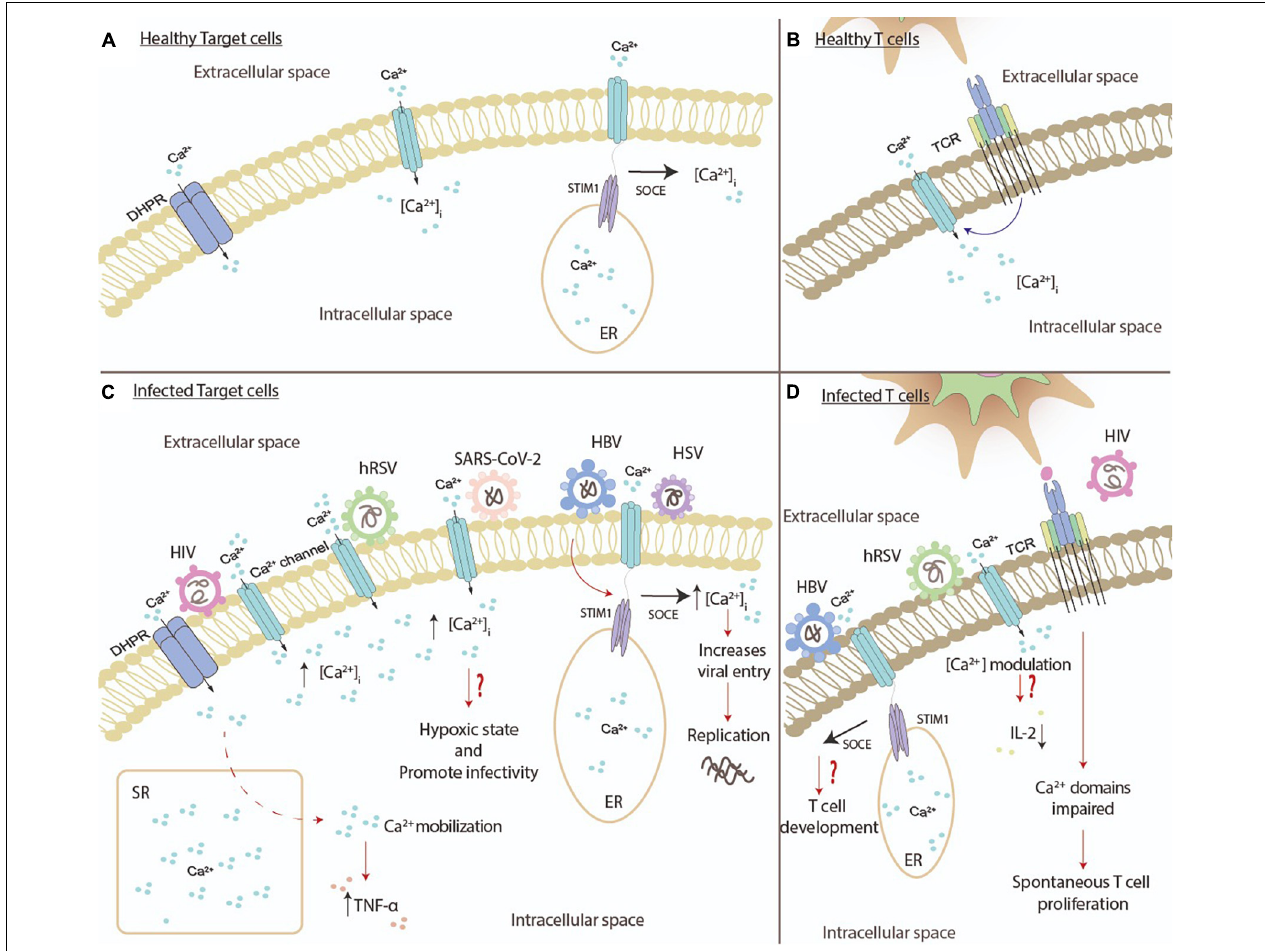
FIGURE 3 | Viral pathogens modify biological processes on immune cells by increasing the Ca 2 + . (A) During normal conditions, various immune cells, such as dendritic cells, monocytes, macrophages, and neutrophils, regulate their concentrations of intracellular Ca 2 + . The activation of dihydropyridine receptor (DHPR) and Ca 2 + channels promote the entry of Ca 2 + into the cells. The interaction between the CRAC channel and STIM1 promotes the movement of Ca 2 + into the cytosol. (B) During normal conditions, T cells regulate their concentrations of intracellular Ca 2 + through the activation of the T cell receptor (TCR). (C) Different viruses can modulate different processes in various immune cells. The human immunodeficiency virus (HIV) can increase the Ca2+ concentration through the modulation of Ca 2 + channels, and the activation of DHPR promotes the mobilization of Ca 2 + that leads to the secretion of TNF- α . The human respiratory syncytial virus (hRSV) promotes the increase of Ca 2 + as well. SARS-CoV-2 might be causing a hypoxic state and increase the infectivity of the virus through the increase Ca 2 + concentration. The hepatitis B virus (HBV) and herpes simplex virus (HSV) can increase the concentration of intracellular Ca 2 + through the interaction between the CRAC channel and STIM1. (D) RNA viruses can modulate different processes in T cells. HIV proteins activate the T cell receptor (TCR), and as a result, it impairs the domains of Ca 2 + , leading to spontaneous T cell proliferation. hRSV induces the influx of Ca 2 + into T cells, which might decrease the secretion of IL-2. As for DNA viruses, such as HBV, the interaction between the CRAC channel and STIM1 might modulate the development of T